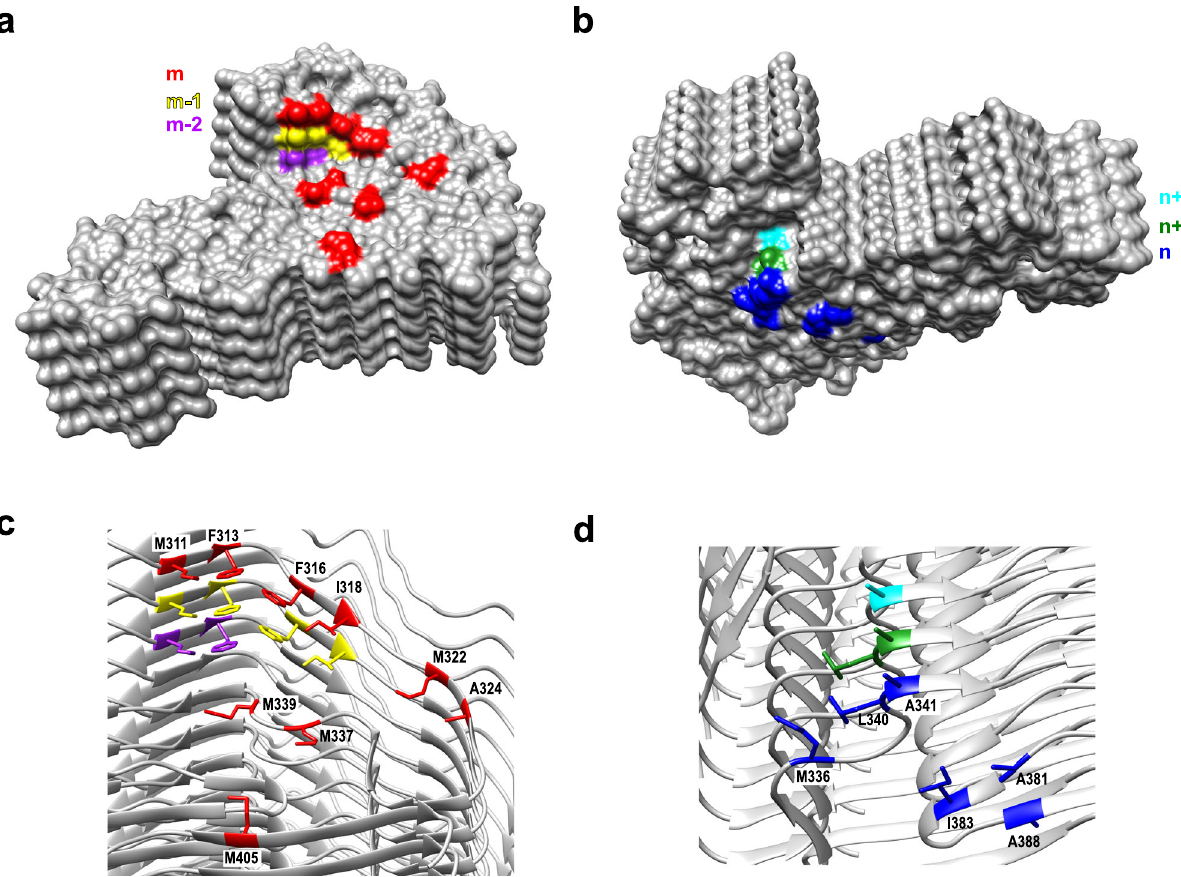
Fig. 3 Rugged surface of the top and bottom ends of TDP-43 LCD fi bril. a , b Surface representation of fi bril ends with solvent-accessible hydrophobic residues from different layers marked in different colors. c , d Ribbon representation of the structure at both fi bril ends. Exposed hydrophobic residues from different layers are labeled using the same color scheme as in a , b . Fifteen hydrophobic side chains from three different layers [M311 (m, m − 1, m − 2), F313 (m, m − 1, m − 2), F316 (m, m − 1), I318 (m, m − 1), M322 (m), A324 (m), M337 (m), M339 (m), and M405 (m)] are exposed to water at the top end. Nine hydrophobic side chains [A341 (n, n + 1, n + 2), L340 (n, n + 1), M336 (n), A381 (n), I383 (n), and A388 (n)] are exposed at the bottom